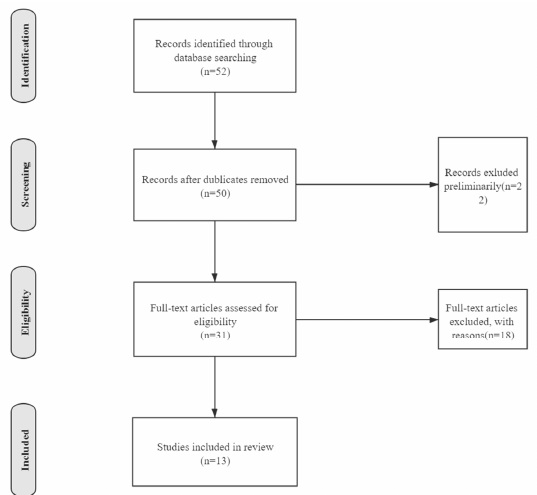
Figure 1. Flow diagram for the process of searching existing literature.